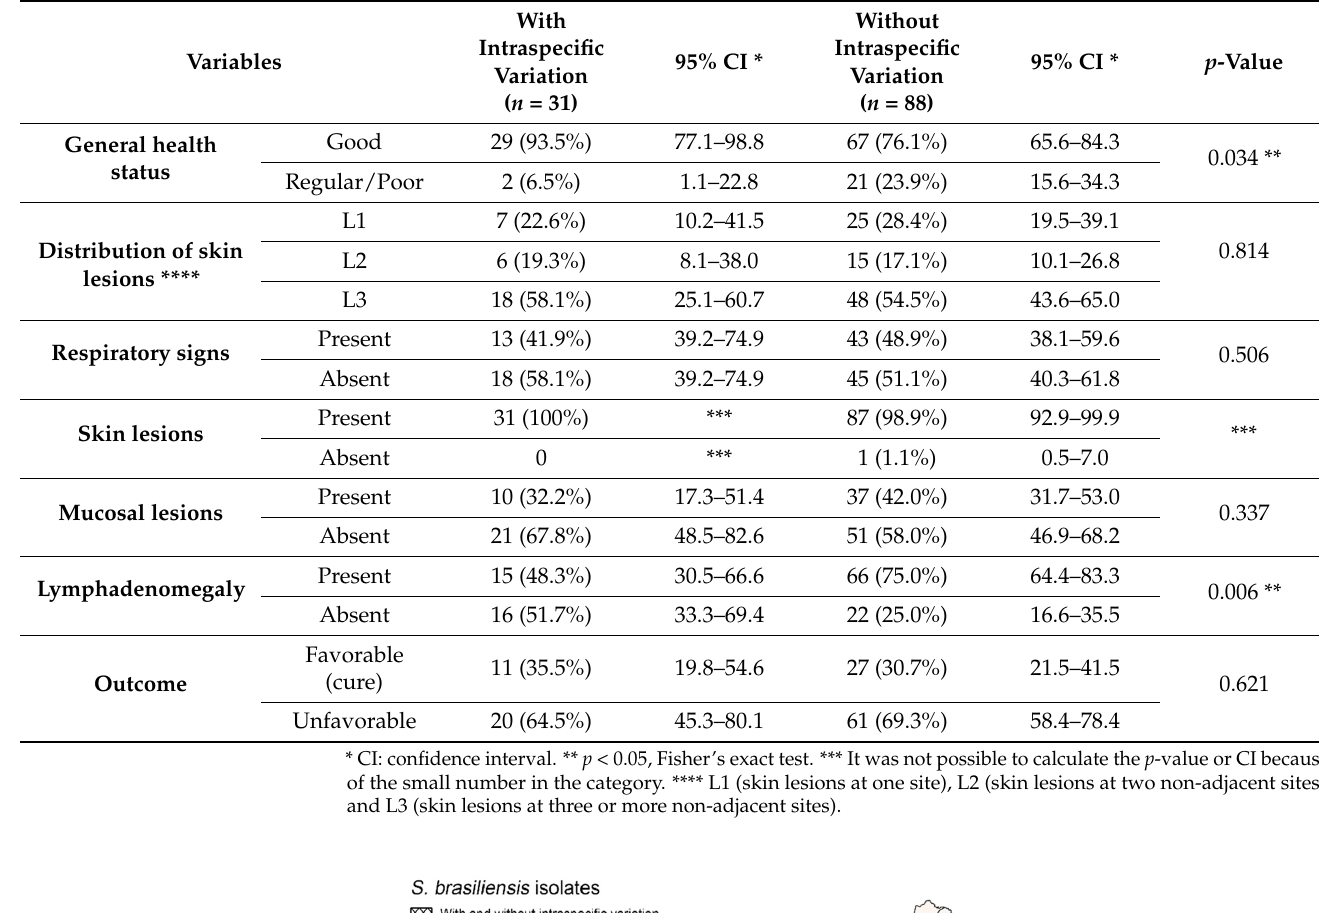
Table 4. Distribution of clinical variables in the 119 cats with sporotrichosis according to the presence or absence of intraspecific genotypic variation in the S. brasiliensis isolates obtained from these animals. Rio de Janeiro, Brazil (1998 to 2018).